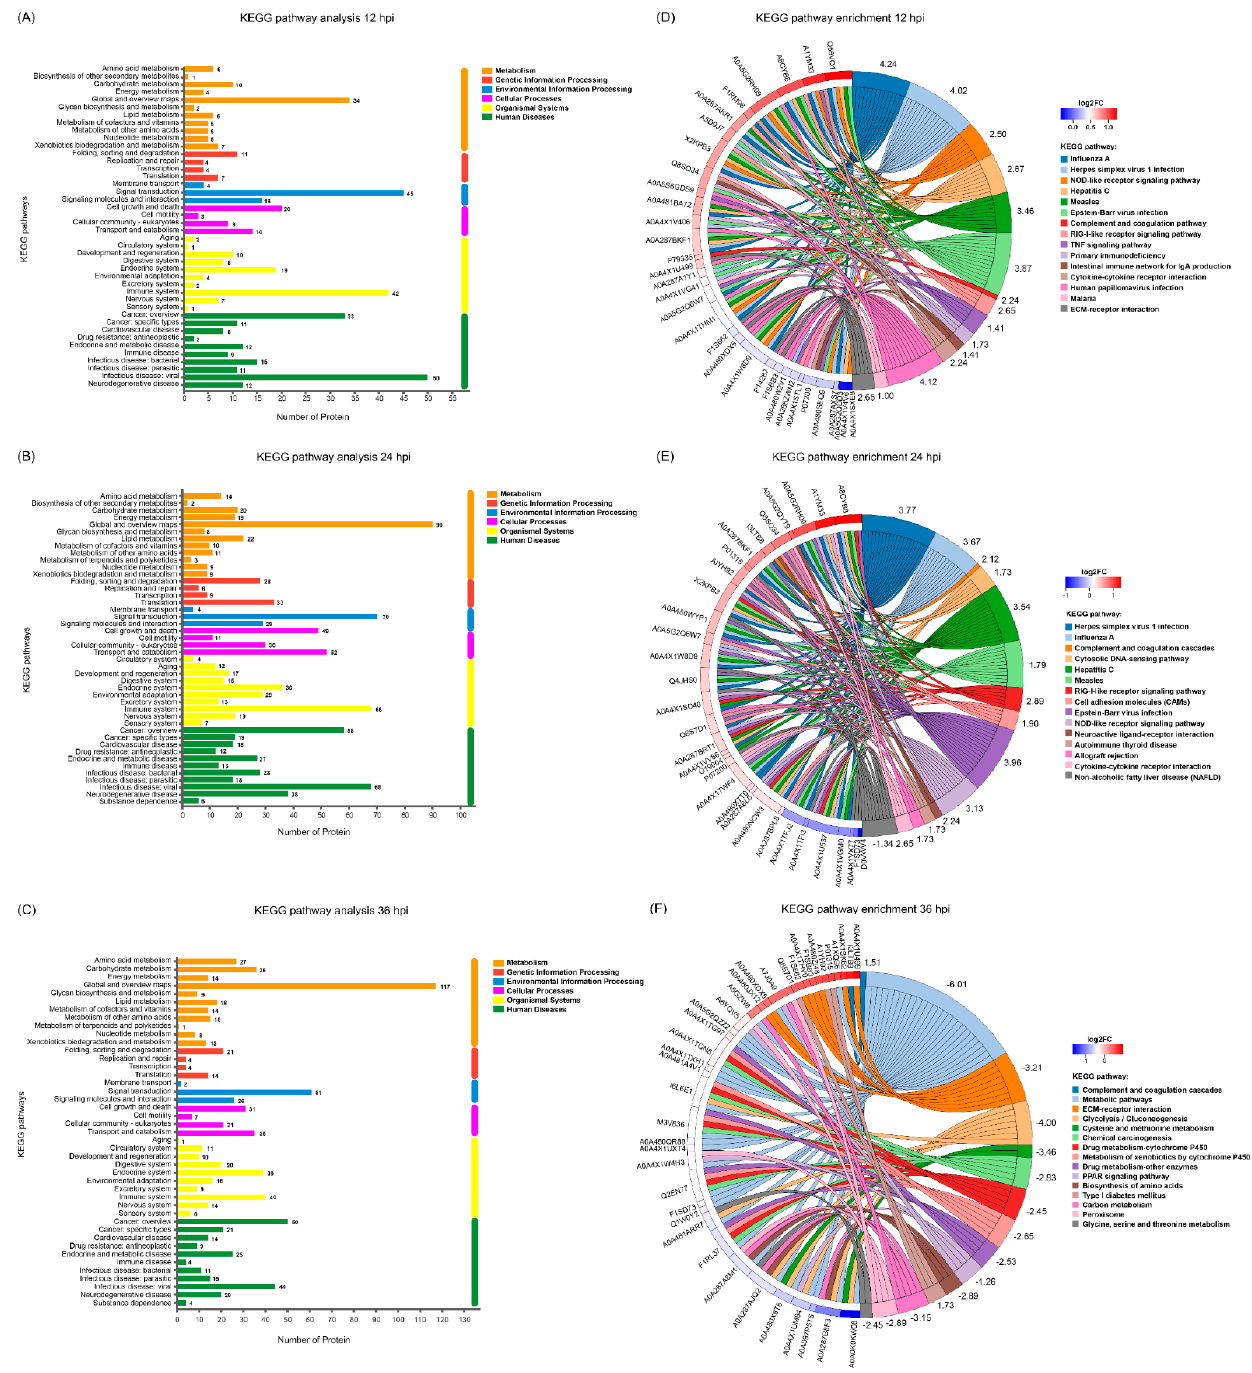
Figure 5. Kyoto Encyclopedia of Genes and Genomes (KEGG) pathway analysis of the DEPs identified in PK-15 cells during SVA infection. ( A – C ) KEGG pathway analyses for the DEPs identified at 12, 24 and 36 hpi, respectively. The different colors indicate 6 first-category KEGG pathways. The Y axis represents the name of each second-category KEGG pathway, and the X axis represents the number of proteins in each second-category. ( D – F ) KEGG pathway enrichment analyses for the DEPs identified at 12, 24 and 36 hpi, respectively. The UniProt accession numbers for the corresponding proteins are marked on the left of the chord diagrams. The log2 fold changes (log2FC) of the upregulated and downregulated proteins are marked with different colors between the red and blue gamut. The names of the top 15 KEGG signaling pathways are marked on the right of the chord diagram in 15 different colors. The Z-scores for the relevant KEGG signaling pathways are also marked on the